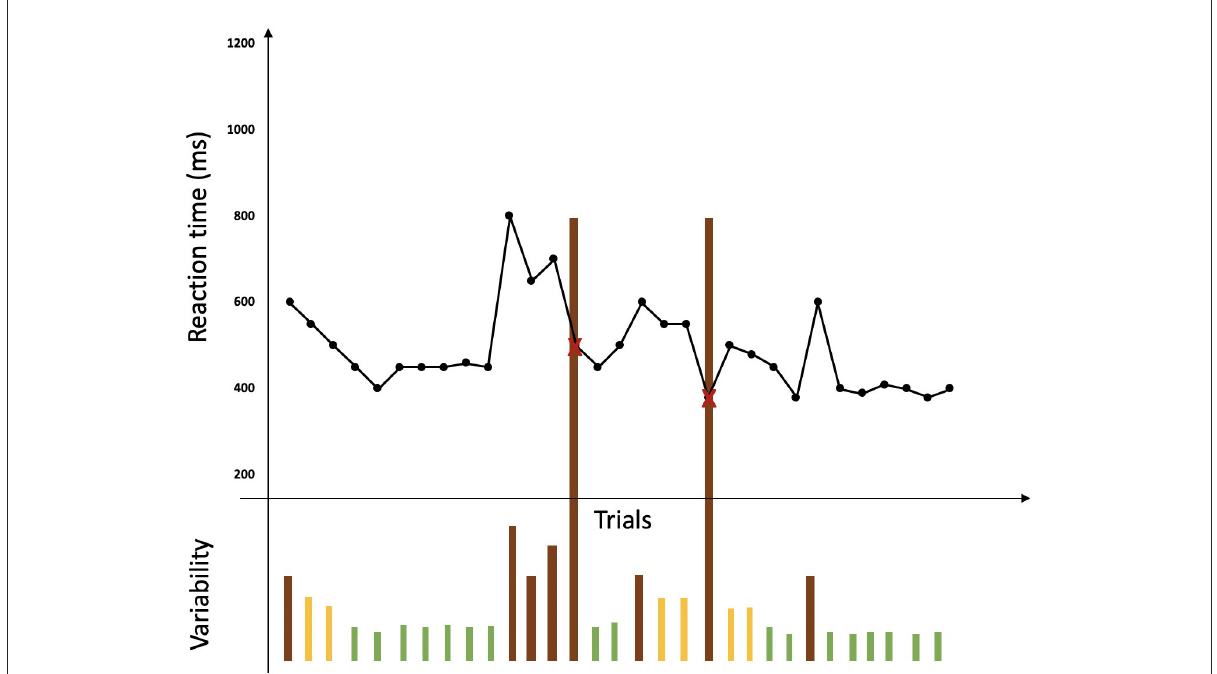
FIGURE3 Representation of a BLAST session adapted from Petton et al. (2019). Reaction times for each trial are represented by a black point and errors are represented by a red cross. No lack of response is represented here. Variability in performance is represented under the curve of reaction times by bars: green bars represent a good stability of performance while orange bars represent instability and brown bars represent lapses associated with errors or a large variability in reaction time.